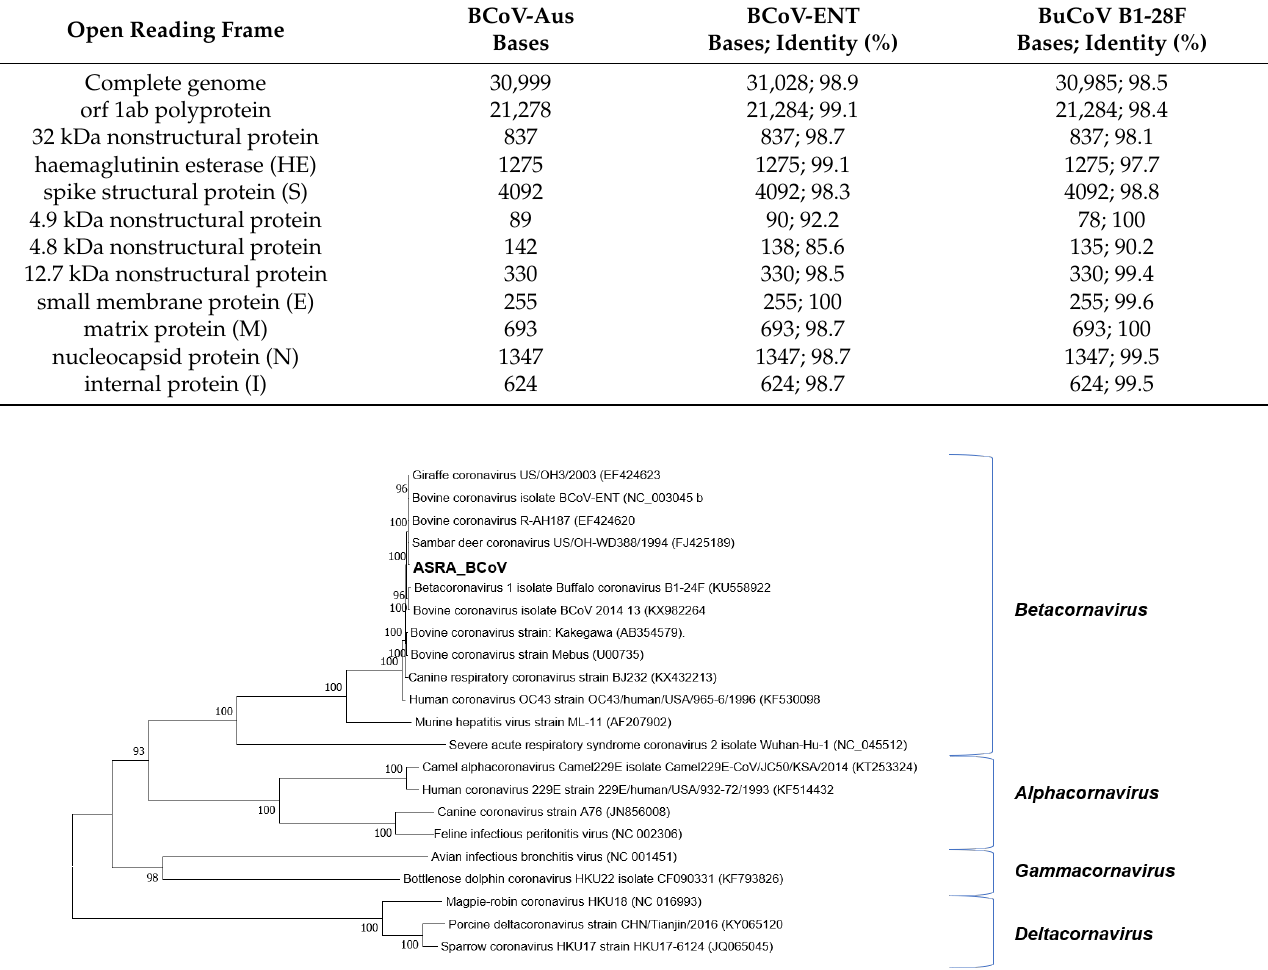
Table 3. Comparison of the Australian bovine coronavirus (BCoV-Aus) genome reconstructed in this study with next-generation sequencing data to the BCoV reference strain BCoV-ENT and the buffalo coronavirus (BuCoV) strain B1-28F.